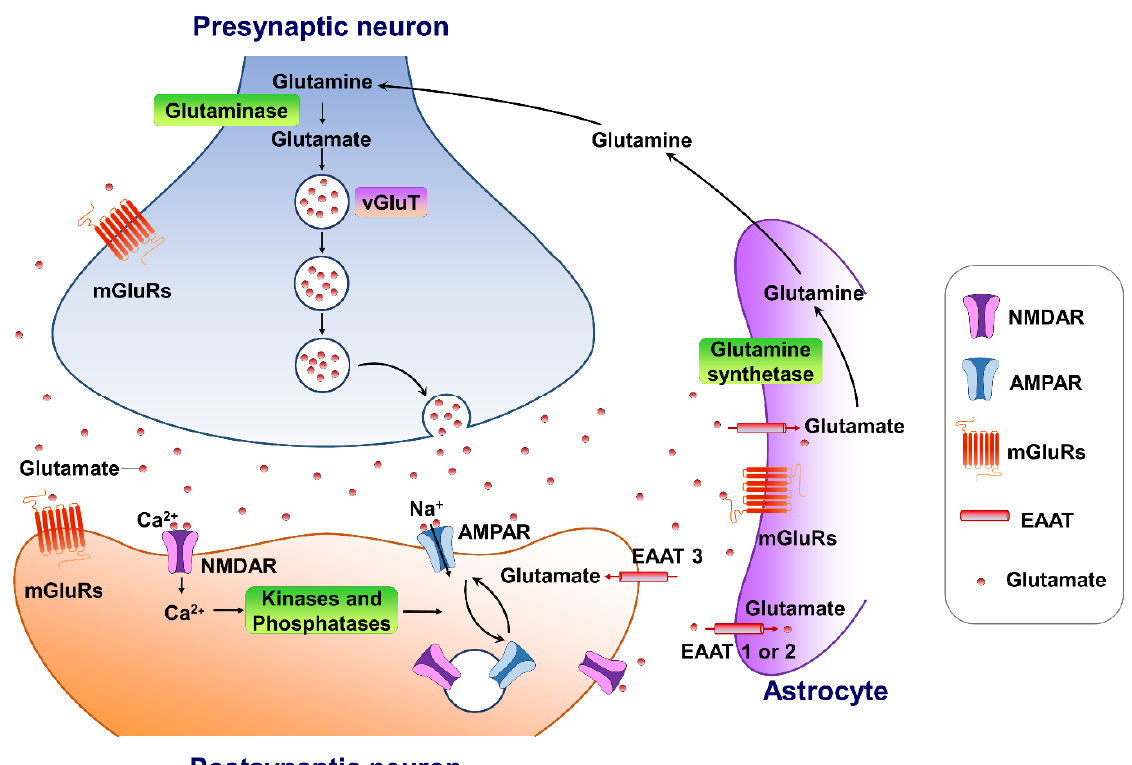
Figure 1. The tripartite glutamate synapses. Most glutamate molecules are cleared from the synaptic cleft through the excitatory amino-acid transporter (EAAT 1/2) located on the astrocytes. Within the astrocyte, glutamine synthetase converts glutamate to glutamine, and the glutamine is subsequently released from the astrocyte and taken up by neighboring neurons to complete the glutamate–glutamine cycle in the brain. Neuronal glutamate is synthesized de novo from glutamine originating from nearby astrocytes. Glutamate is then loaded into synaptic vesicles by vesicular glutamate transporters (VGLUTs). Upon being triggered by an action potential, glutamate will be rapidly released into the synaptic cleft. Here, glutamate binds to either ionotropic glutamate receptors (AMPA receptors and NMDA receptors) and/or metabotropic glutamate receptors (mGluRs) on the membranes of both postsynaptic and presynaptic neurons and astrocytes. Upon activation, these glutamate receptors initiate various cellular responses, including depolarization of